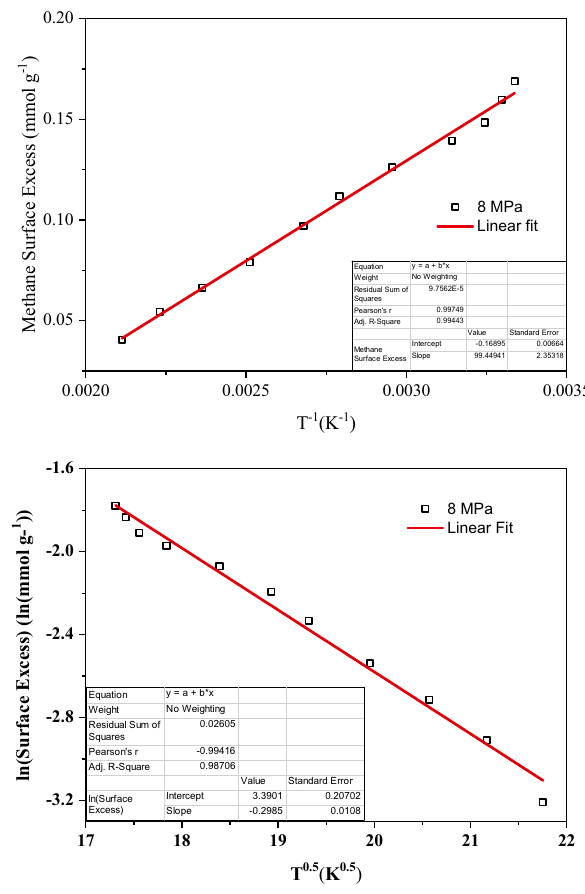
Fig. 5 Subcritical adsorption isotherms for CH and CO (195 K) for Alum 1 shale 2